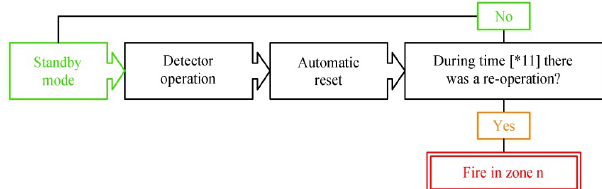
Figure 3. Algorithm for checking the re-activation of the